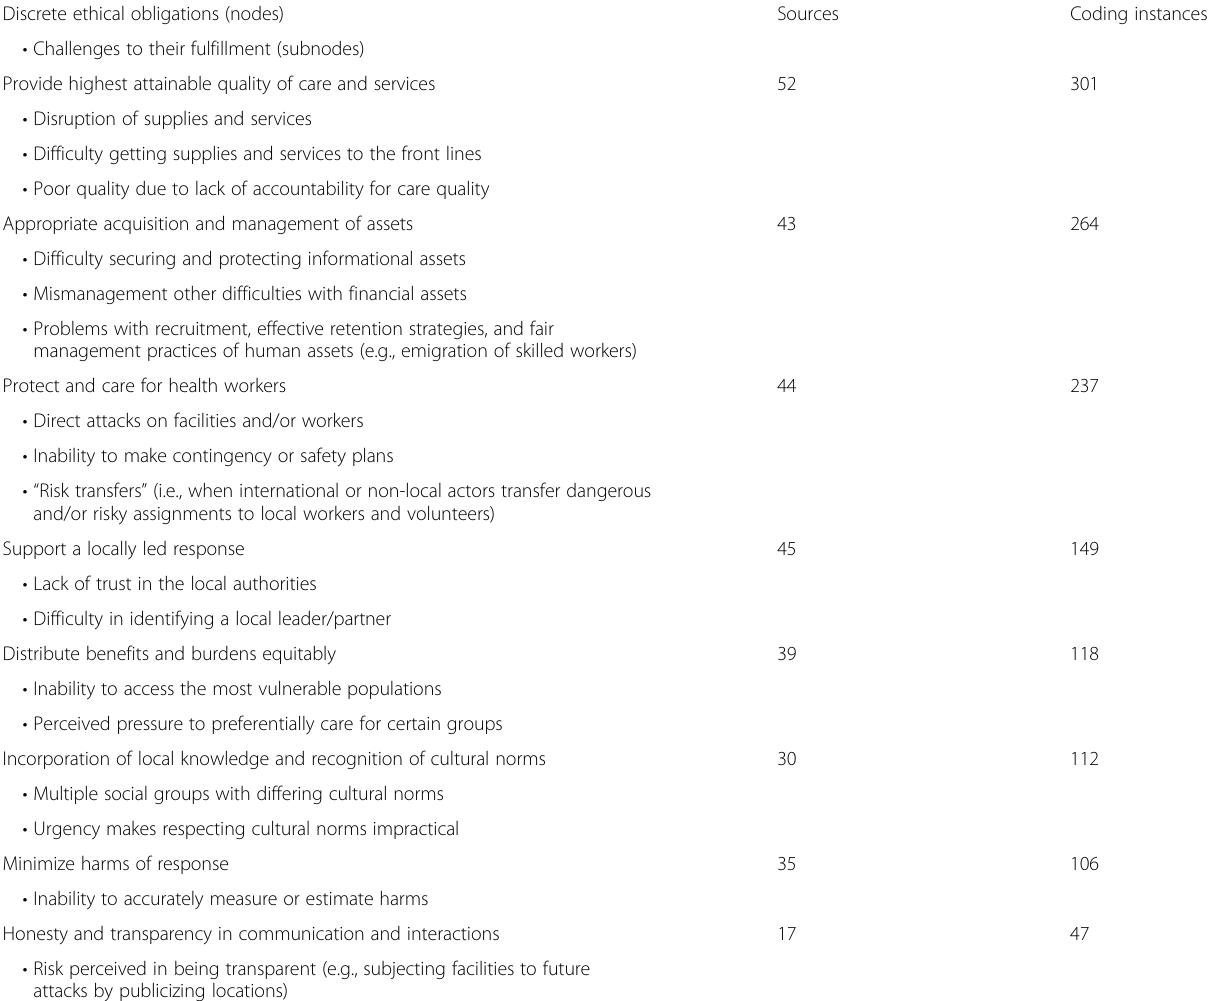
Table 1 Coding frequencies of ethical obligations, including the top coded challenges Discrete ethical obligations